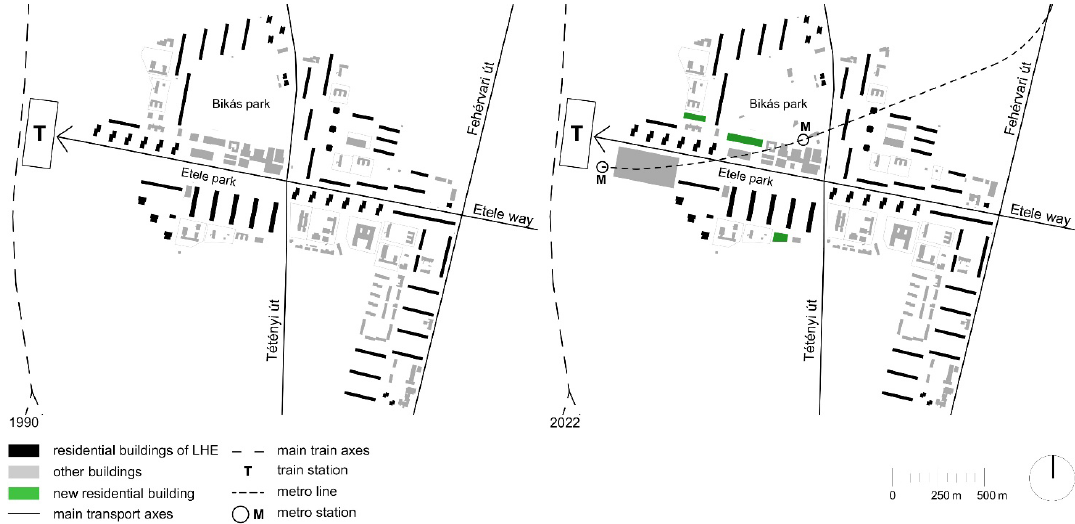
Figure 6. Kelenföld residential buildings in 1990 and 2022 (source: author)